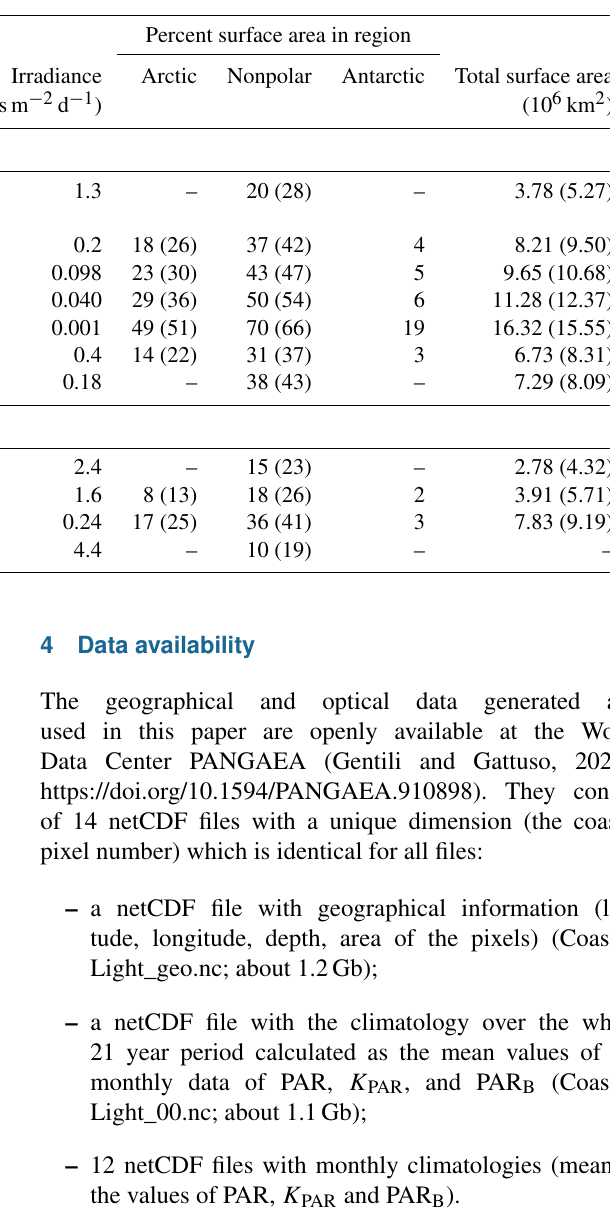
Table 5. Top: Organisms. Surface area (percent of the coastal zone) where irradiance does not limit the distribution of photosynthetic organisms. Values reported by Gattuso et al. (2006) are shown in parentheses for comparative purposes. The irradiance thresholds are the first deciles of the minimum light requirements compiled by Gattuso et al. (2006). Data are not reported in the Arctic region for seagrasses and scleractinian (reef-building) corals where these groups are not present. Bottom: Communities. Surface area (percent of the coastal zone) where benthic irradiance is higher that the daily community compensation irradiance (net primary production > 0). The irradiance thresholds are the first deciles of the minimum light requirements compiled by Gattuso et al. (2006). Data are not reported for seagrass communities and coral reefs in the Arctic and Antarctic regions where they do not occur.